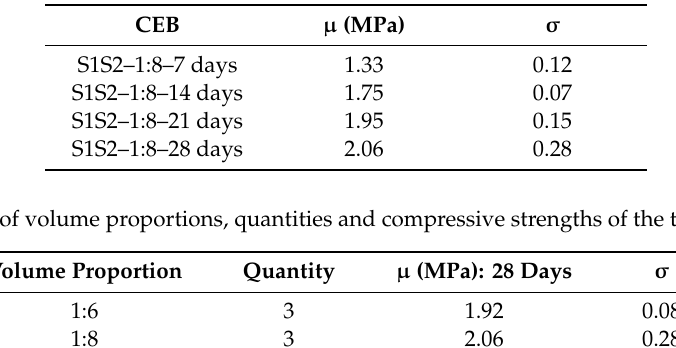
Table 2. Compressive strengths of the tested CEBs with a 1:8 volume proportion [39].